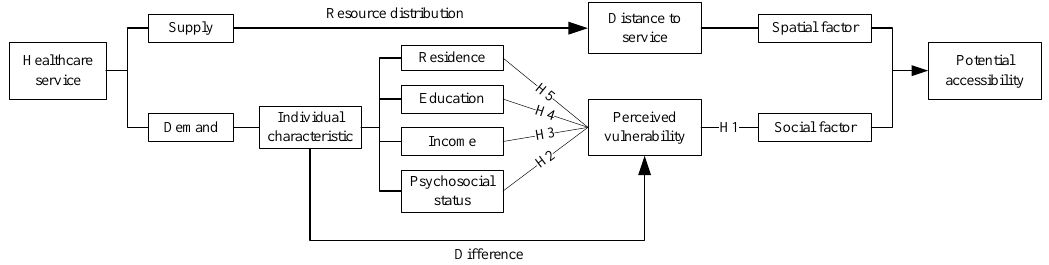
Figure 1. Analysis framework and hypotheses.